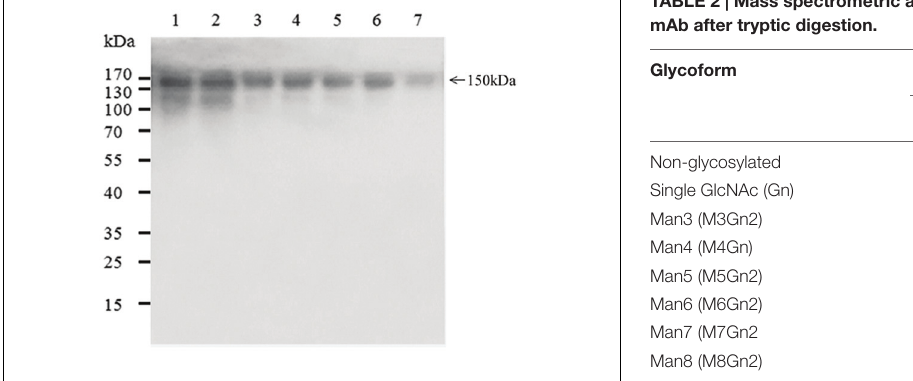
FIGURE 4 | SDS-PAGE of purified Bevacizumab mAb in transgenic rice. 5 µ g (lane 1), 2 µ g (lane 3), and 1 µ g (lane 5) mAbs purified from pUNBevaHL transformed rice callus, 5 µ g (lane 2), 2 µ g (lane 4), and 1 µ g (lane 6) mAbs purified from pUNBevaHL-KDEL transformed rice callus, and 0.5 µ g commercial Bevacizumab mAb (lane 7) were analyzed by non-reducing SDS-PAGE and stained with Coomassie blue. The major 150 kDa mAb band was indicated.